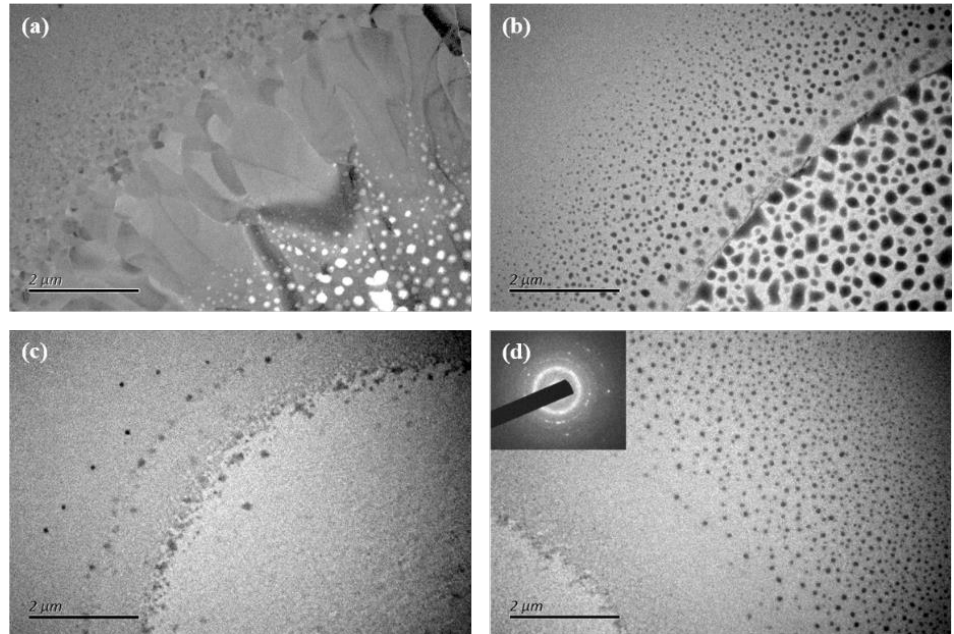
Figure 7. ( a ) TEM images of irradiated pure GST films with a fluence of 0.023 J/cm 2 , ( b ) TEM images of irradiated 2:1 films with a fluence of 0.023 J/cm 2 , ( c ) TEM images of irradiated 2:2 films with a fluence of 0.023 J/cm 2 , ( d ) TEM images of irradiated 2:2 films with a fluence of 0.021 J/cm 2 . To study the threshold of different kinds of films on the laser fluence, the pure GST and different nitrogen content films are focused through the same lens used in the reflec- tive-type pump-probe experiments by single femtosecond laser pulses. The distance be- tween the focal lens and the sample kept as the focal distance was studied in the experi- ments. Single-pulse laser beams with different fluence were used to explore the relation- ship between the laser power and the spot size. As the laser fluence increases, the phase state of the films changes first. Then, the films are ablated. The experiments were carried out three times, and the relation between the laser fluence and the average diameter of the films ablated by a single pulse is shown in Figure 8.